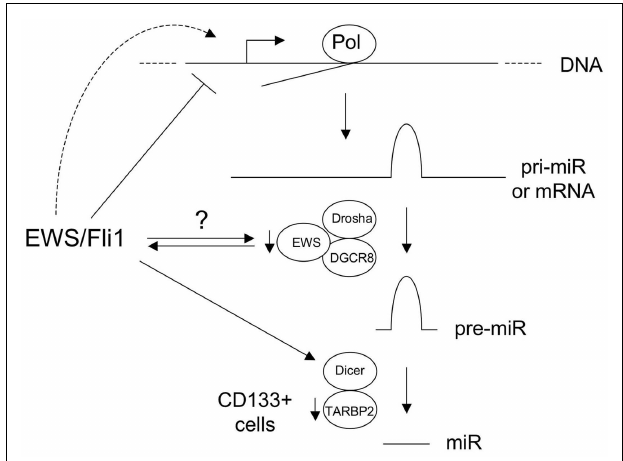
FIGURE 1 | Known and hypothetical mechanisms of altered microRNA (miR) expression in Ewing sarcoma. Basic pathway for biogenesis of majority of miRs is shown, including those derived from non-coding RNA precursor transcripts (pri-miR) and protein-coding mRNAs. EWS/Fli1 represses some miRs at the transcriptional level, through direct and indirect mechanisms, and likely also transcriptionally activates other miRs. EWS is a component of the Drosha/DGCR8 miR processing complex, and the copy number of the wild-type intact form is reduced in Ewing sarcomas with EWS-containing fusions. EWS/Fli1 can also interact with EWS.The consequences of this to miR biogenesis are currently unknown. Dicer is upregulated by EWS/Fli1; the consequences of this in Ewing Sarcoma are unknown, but Dicer levels impact oncogenesis in other cancers.TARBP2 downregulation in CD133 + Ewing Sarcoma cells results in diminished expression of a number of miRs. (Pol: RNA Polymerase.) See text and references for more